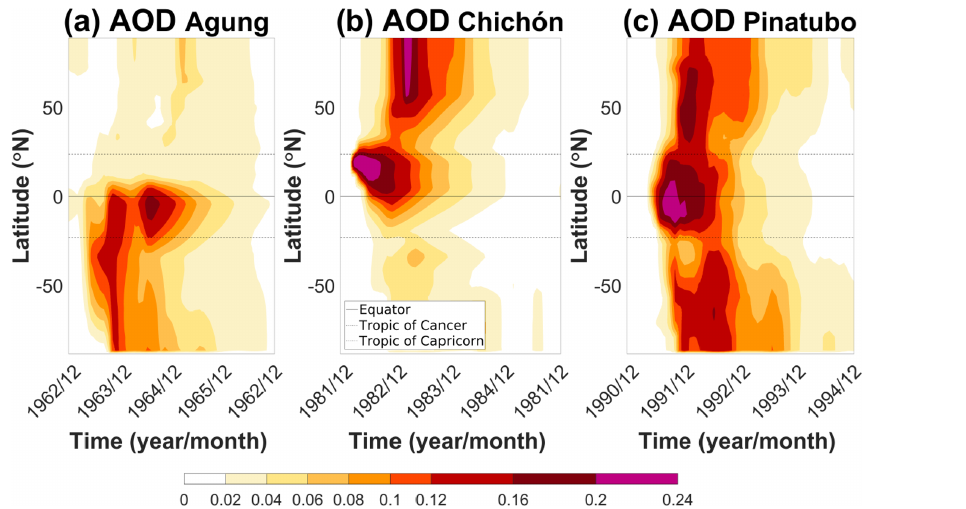
Figure 1. Evolution of the aerosol optical depth during 4 years for the three eruptions. The band of wavelength used is between approximately 462 and 625nm.